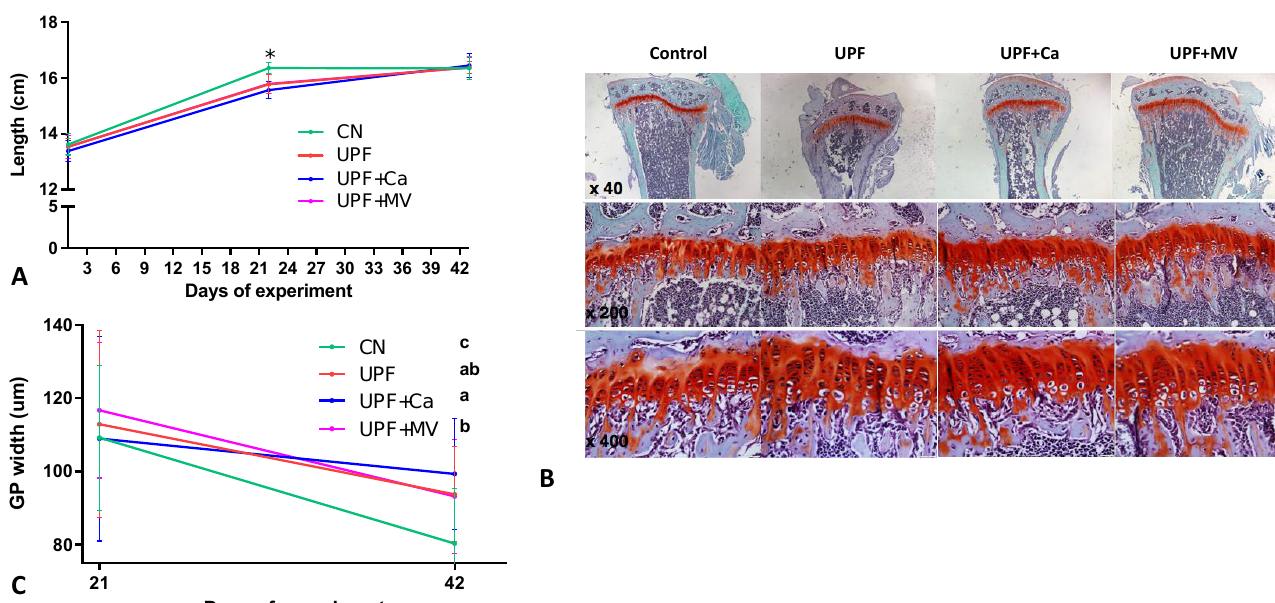
Figure 2. UPF effect on longitudinal growth of mice at 6 and 9 weeks of age. ( A ) Total length from nose to tail (cm) ( B ) Tibiae from the different groups were dissected, processed and stained with safranin-O at 9 weeks of age (end of the experiment) ( C ) Growth plate thickness ( μ m) of each GP was measured at 11 selected locations throughout the GP. The zones selected for measuring of the GP included the resting, proliferating and the hypertrophic zone. Values are expressed as mean ± SD, n = 8. Different letters denote p < 0.05 between groups, * p < 0.05 compared to control. CN – control, UPF – ultra processed food, UPF+Ca - ultra processed food supplemented with calcium, UPF+MV - ultra processed food supplemented with multivitamin and mineral complex.